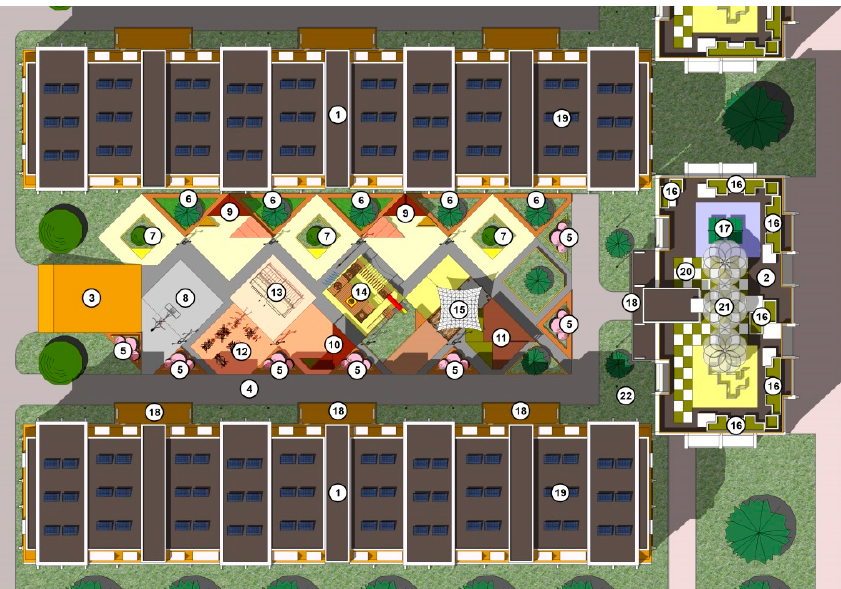
Figure 21. Residential yard reconstruction project (Author’s material). 1: Reconstructed 4-story